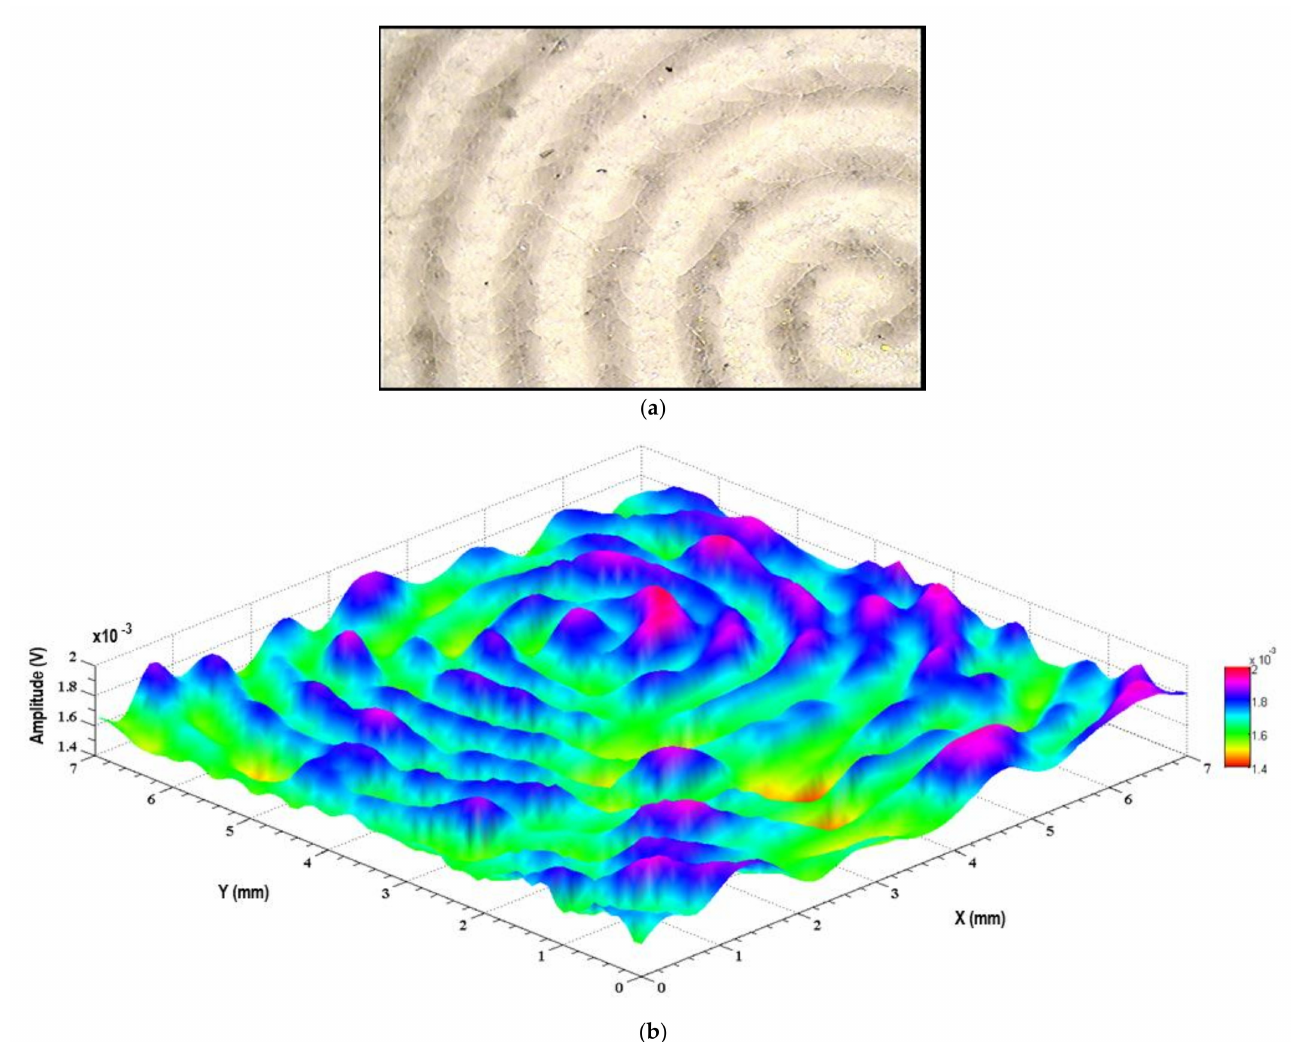
Figure 6. Surface morphology of the SSZ03 sample with laser annealing using 1.38 W/cm 2 of power density: ( a ) optical microscopy image and ( b ) mapping of infrared emission induced by 520 nm